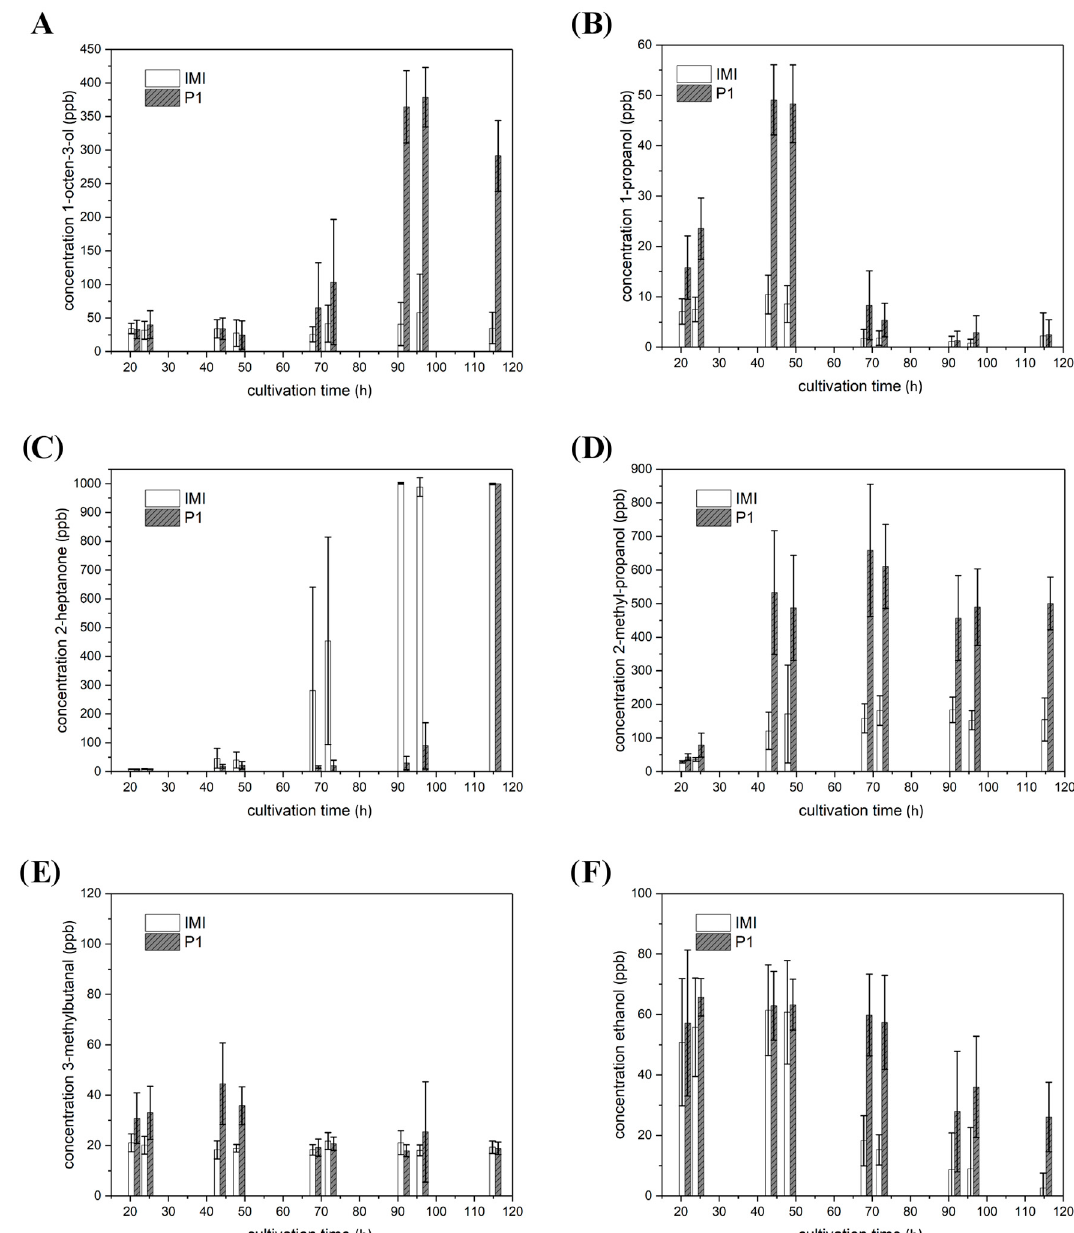
Figure 4. VOCs produced by T. atroviride P1 and IMI 206,040 in a strain-specific but light-independent manner. Levels (ppb) of ( A ) 1-octen 3-ol, ( B ) 1-propanol, ( C ) 2-heptanone, ( D ) 2-methyl-propanol, ( E ) 3-methylbutanal, and ( F ) ethanol detected in the headspace of T. atroviride P1 (P1) and T. atroviride IMI 206040 (IMI) cultures grown on PDA in Schott bottles. GC–IMS measurements were conducted along a cultivation period of 120 h. As the given volatiles were produced in similar amounts under light-dark conditions and in complete darkness, results shown are means ± SD ( n = 8).